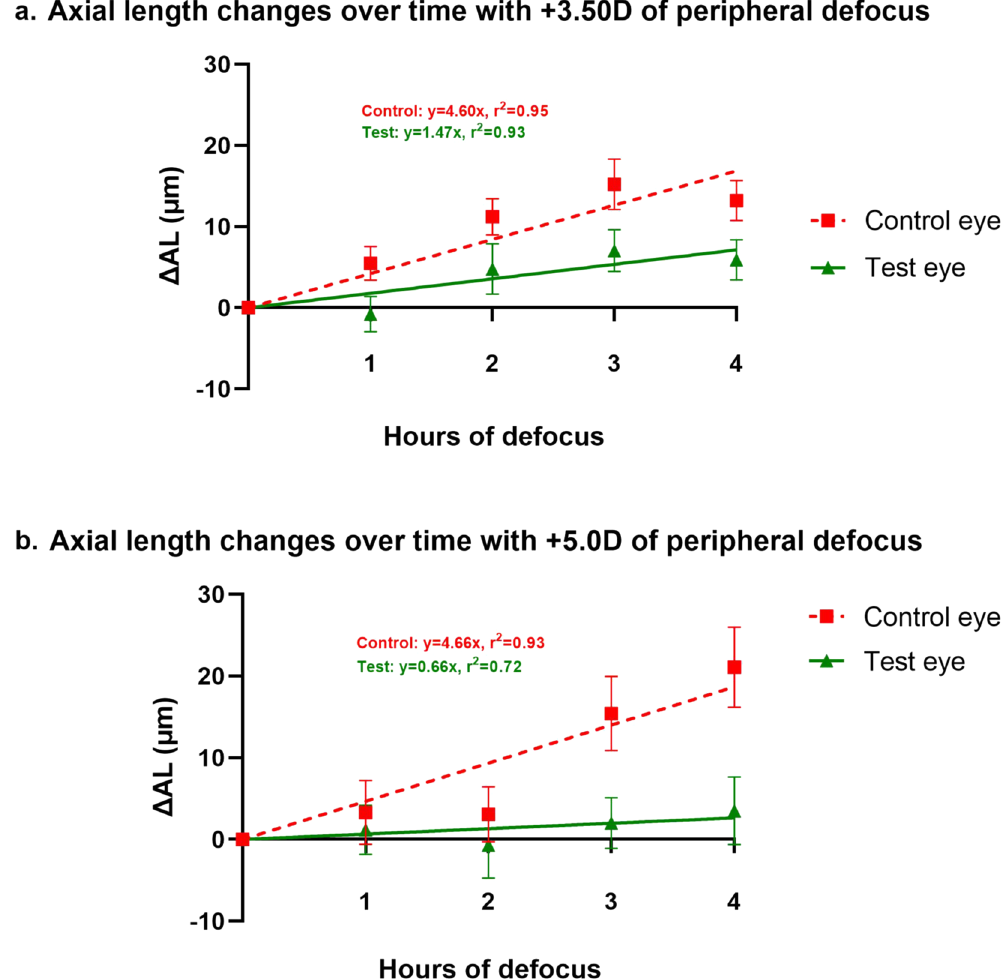
Figure 4. ( a , b ) Linear straight line-fits showing mean change in axial length ± SEM in microns over time for + 3.50 D and + 5.00 D of peripheral defocus